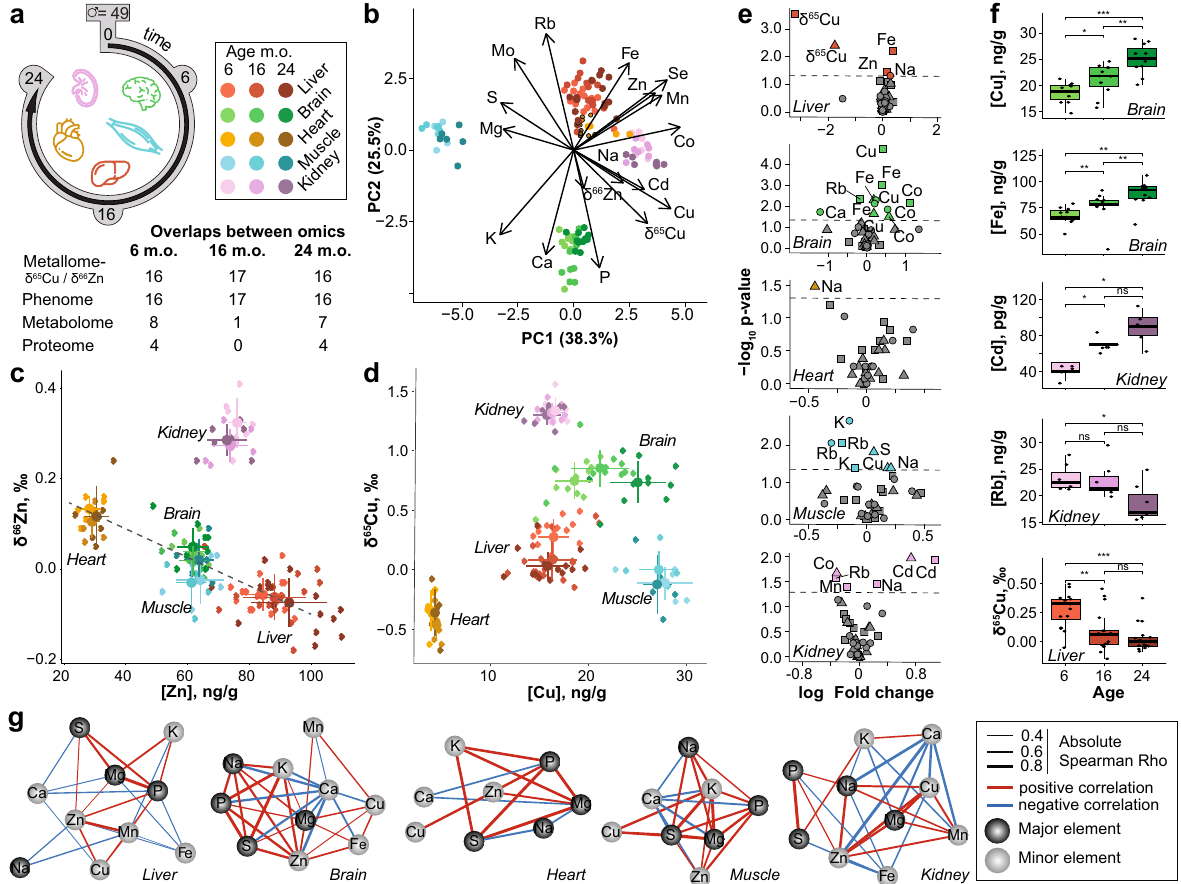
Fig. 1 Organs have distinct metallomic fi ngerprints, that evolve with aging. a Study design and overlapping samples between omic layers. Icons